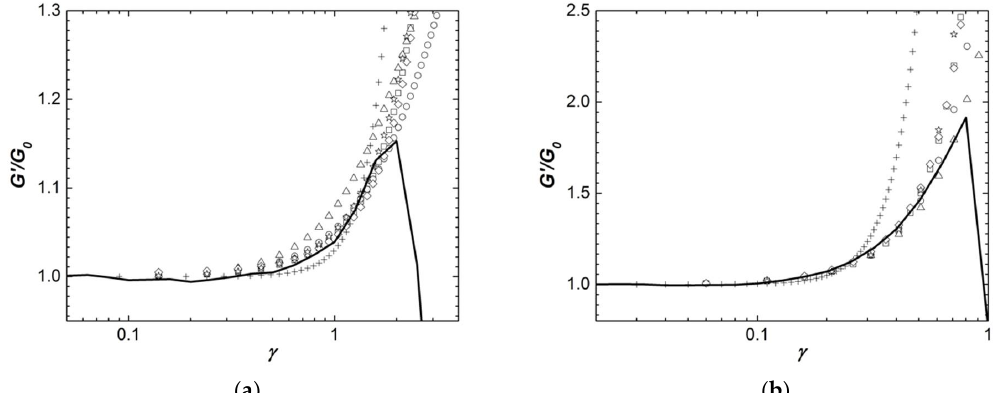
Figure 8. Strain dependence of the shear storage modulus G′ scaled by the linear shear modulus G 0 , plotted as lines and measured with: ( a ) Iota gel with 0.3 wt.%; ( b ) Kappa2 gel with 0.5 wt.%. The symbols represent the following equations computed with the parameters listed in Table 5: Equation (1), squares; Equation (2a), circles; Equation (3), triangles; Equation (4), diamonds; Equation (5), stars; Equation (6a), crosses.